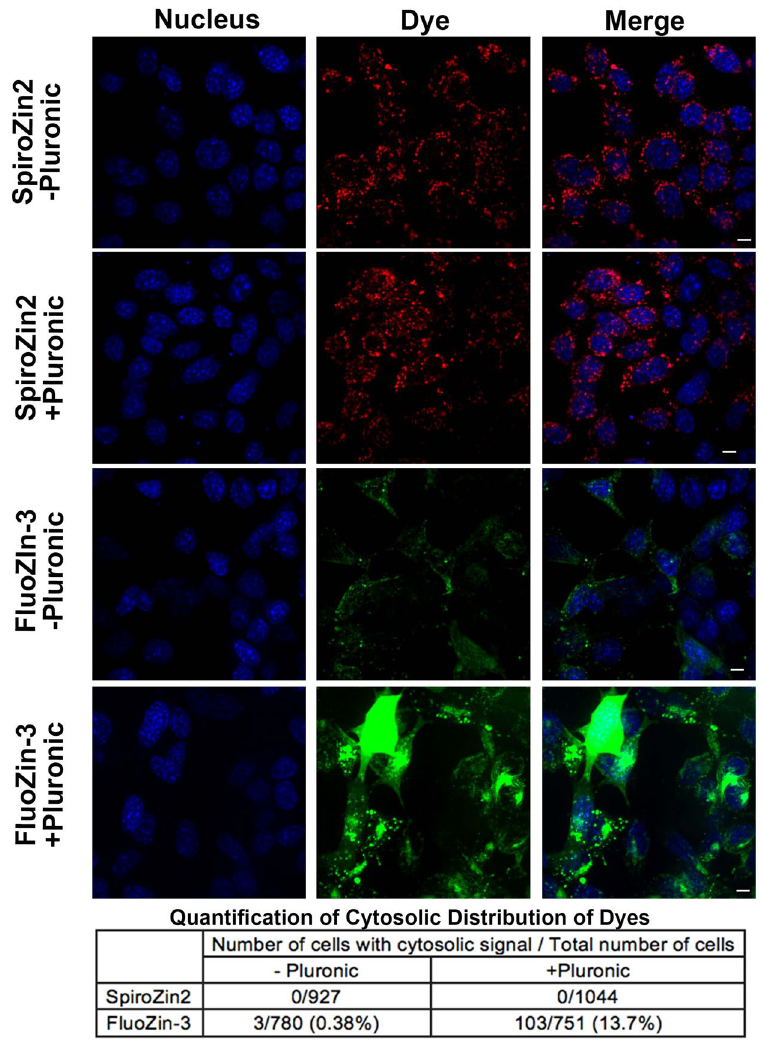
Figure 5. A population of FluoZin-3 localizes to the cytosol. HC11 cells were stained with SpiroZin2 or FluoZin-3 with and without pluronic. Fluorescence images in each channel were acquired 5 min post treatment with 5 μ M pyrithione/20 μ M ZnCl 2 . Quantification reveals that SpiroZin2 does not localize to the cytosol but the cytosolic localization of FluoZin-3 depends on the presence of pluronic. Scale bar, 5 μ